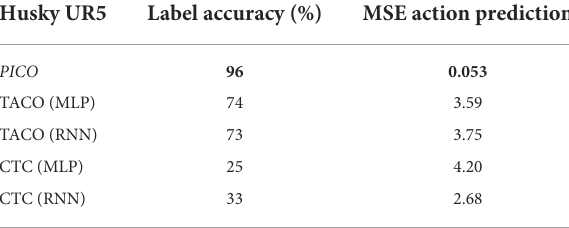
TABLE 1 Method comparisons using the Husky UR5 Reach and Grasp